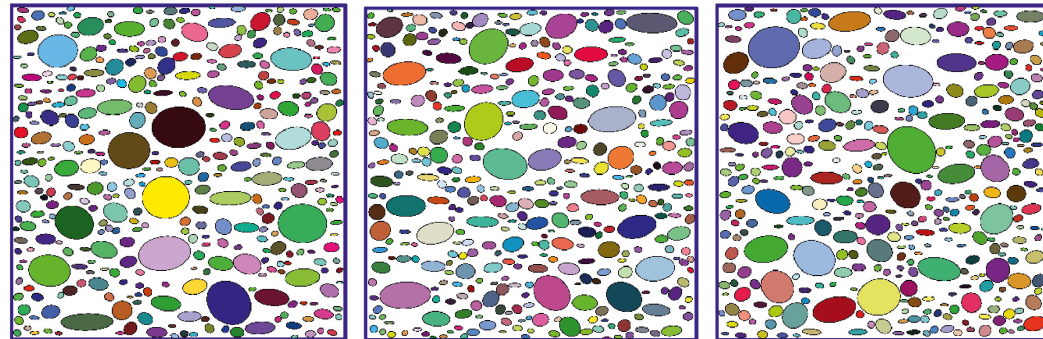
Figure 2: Elliptical and circular random mix aggregate with same geometric parameters ( r